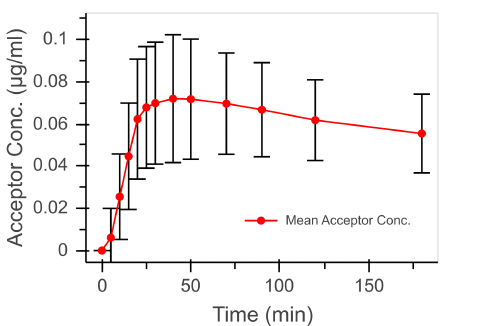
Figure 8. Mean acceptor concentration with standard deviation from experiments with dynamic dilution (n =